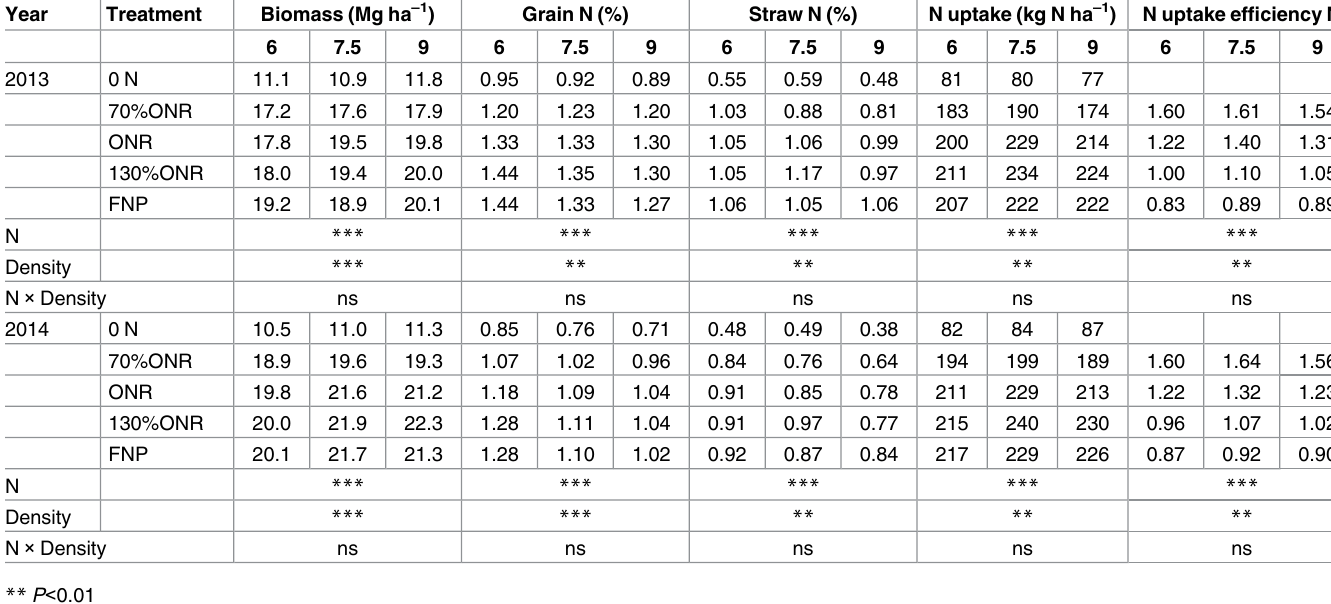
Table 2. Maize biomass, grain and straw N concentration, N uptake, and uptake efficiency at harvestin 2013and 2014 for plant densities of 6.0, 7.5, and 9.0 plants m –2 , and all N treatments. N treatments includeda no N control (0 N), optimalN rate basedon in-seasonroot zone N management (ONR), 70%ONR, 130%ONR, and farmers’ standardN practice